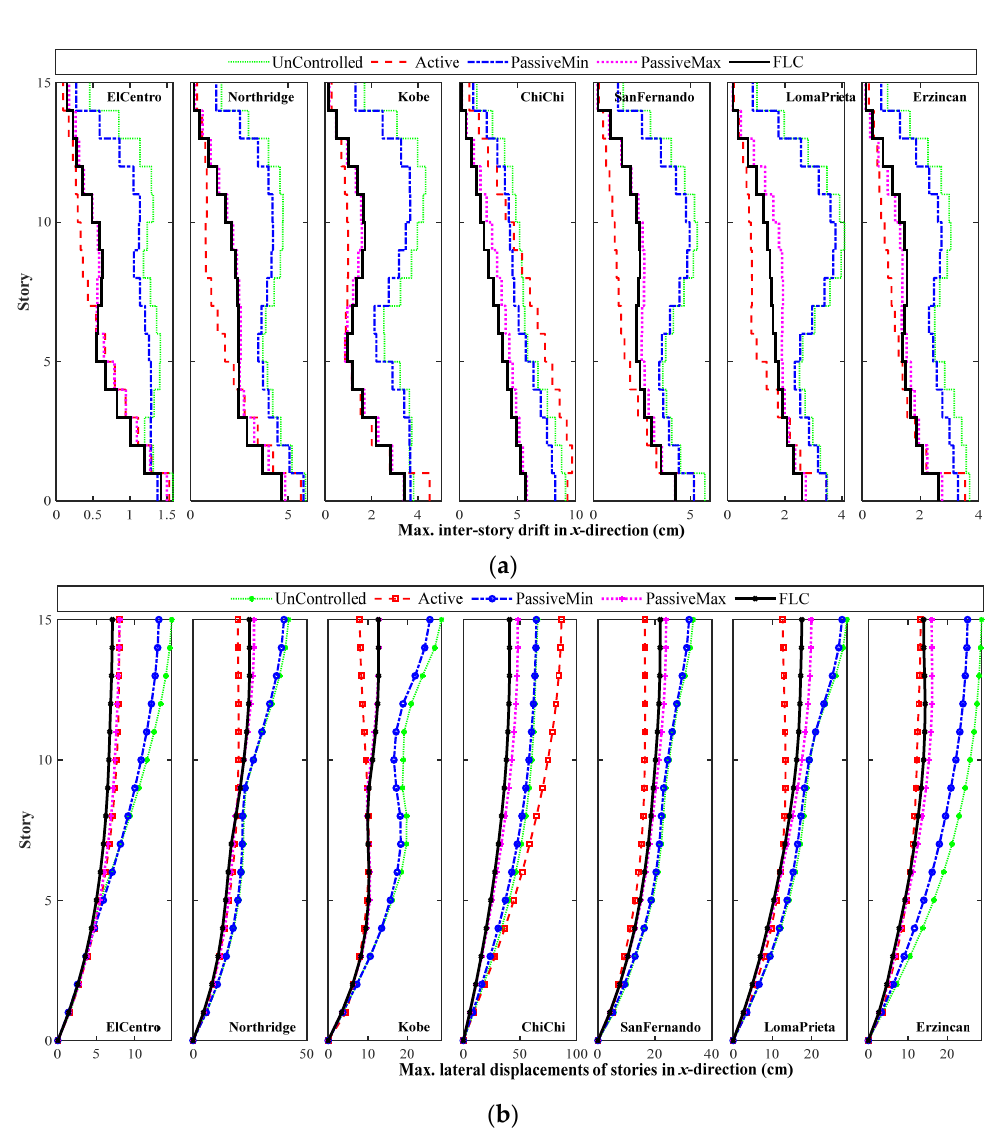
Figure 12. Maximum lateral inter-story drifts, ( a ), and maximum lateral displacements, ( b ), of the Case-I building in the x -direction (soft soil).